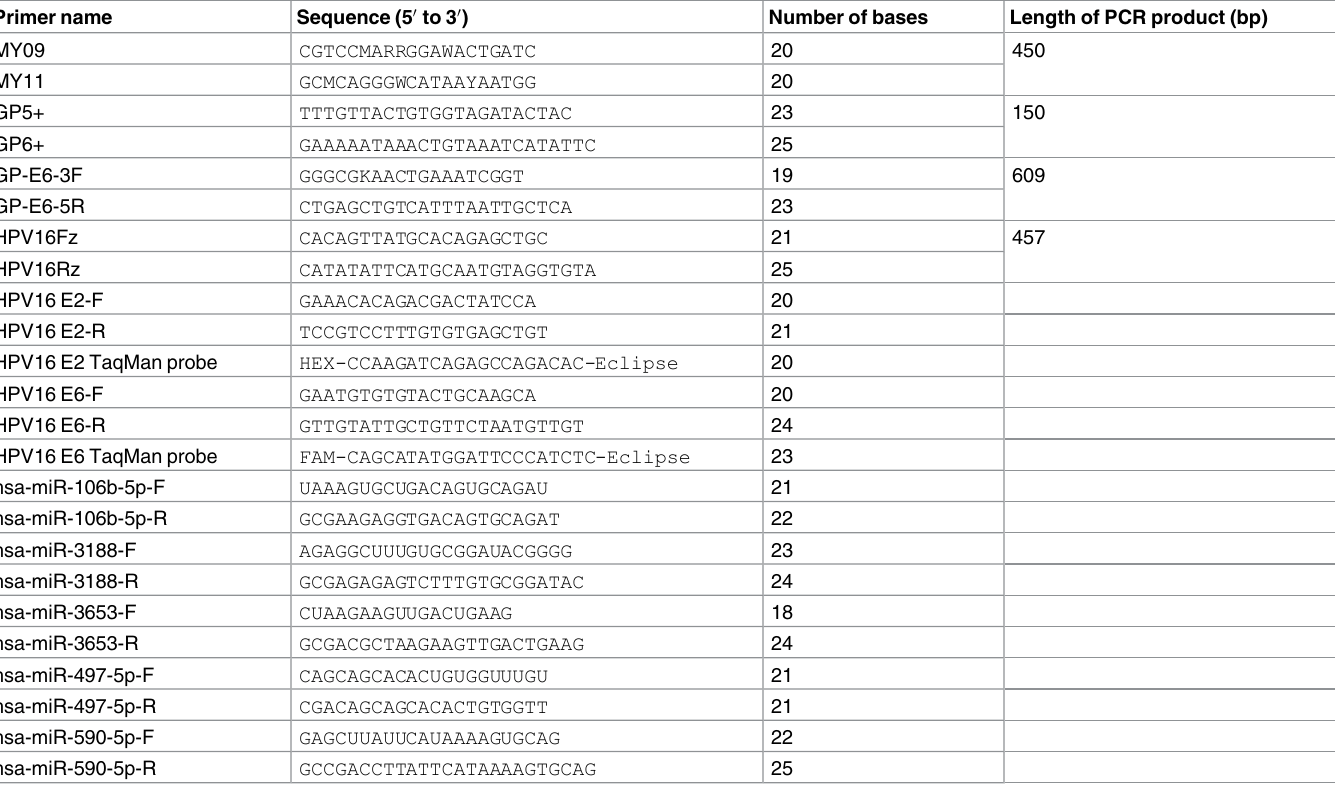
Table 1. Details of all primers used in the